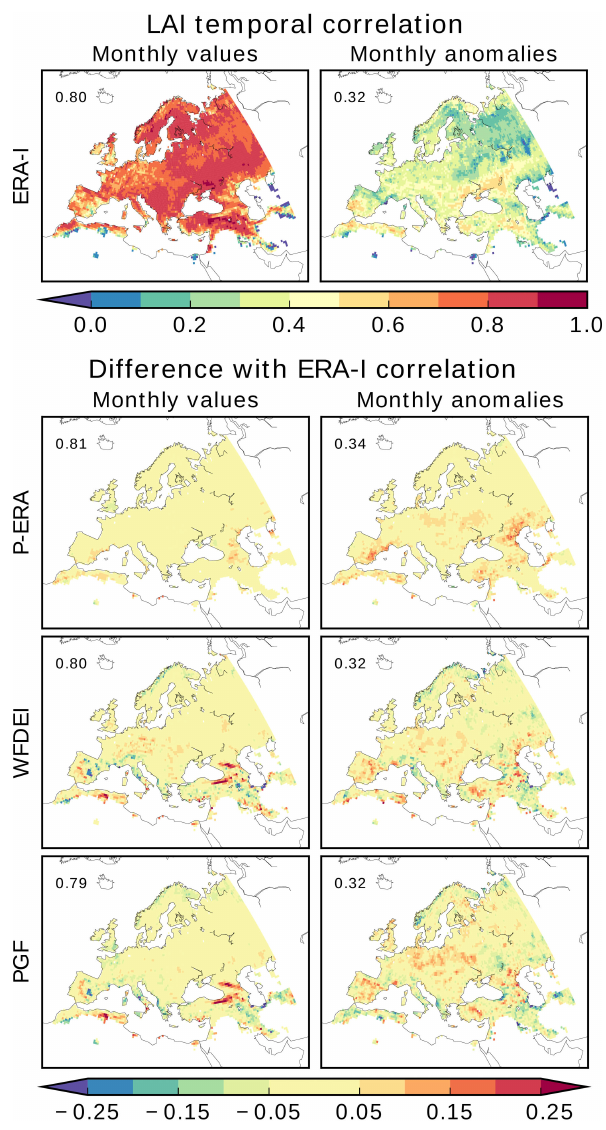
Figure 5. Temporal correlation between modelled and remotely sensed GIMMS LAI for monthly averages and anomalies. Global correlation coefficients are reported in the upper left corner of each